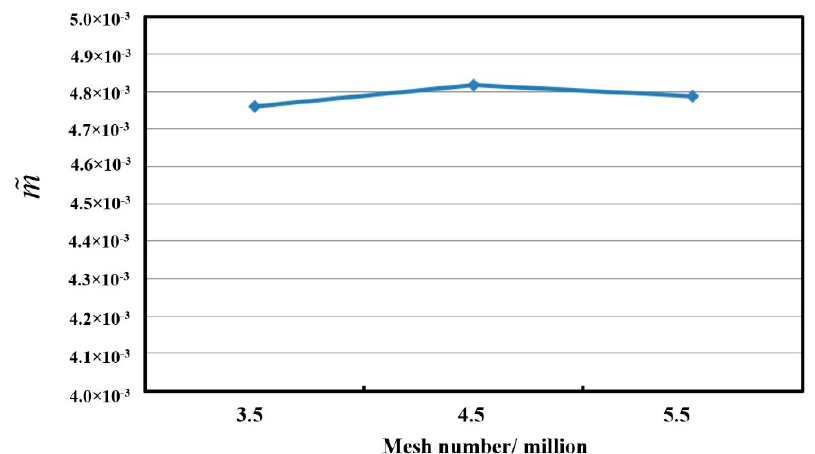
Figure 6. Mesh Independence Study.